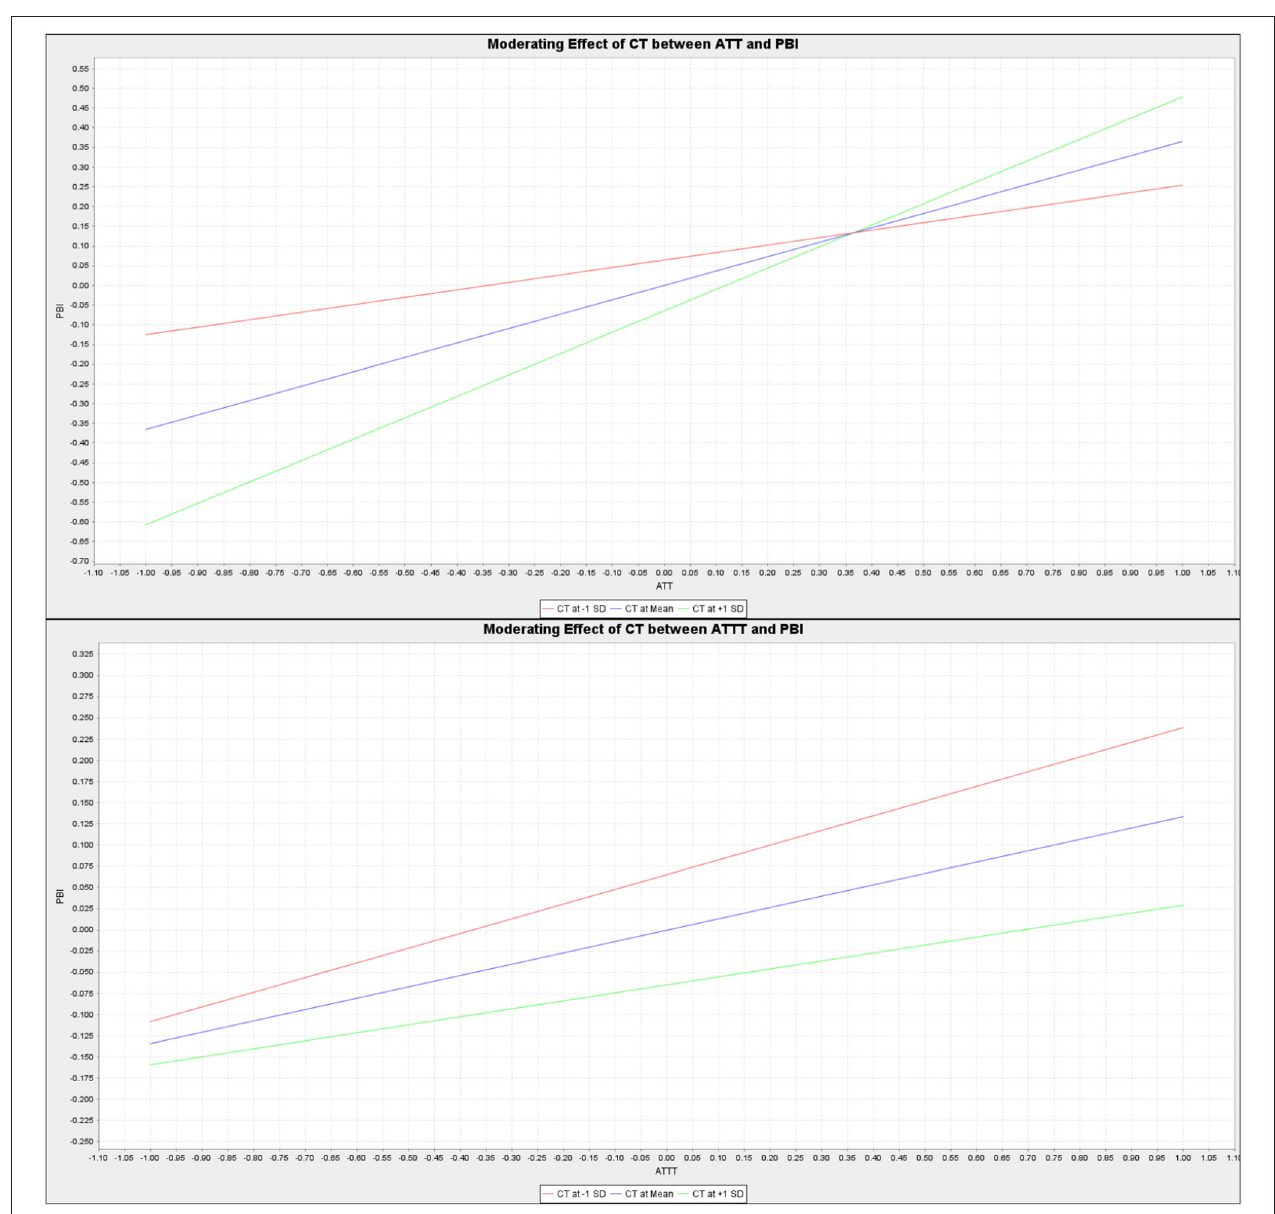
FIGURE 2 | Moderating effect of